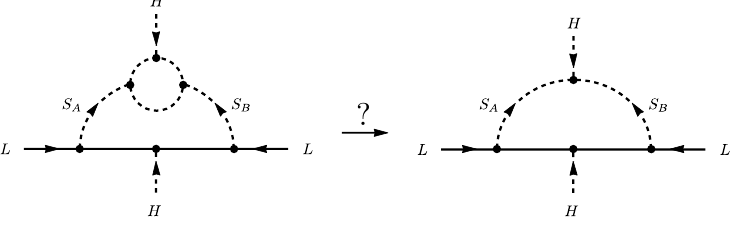
Figure 4 . This 2-loop realization of the dimension (cid:12)ve Weinberg operator illustrates a loophole in our automatized algorithm for (cid:12)nding genuine n -loops neutrino mass diagrams and topologies (we therefore track these special cases manually). In particular, if the scalar S A (or S B ) is the Higgs (cid:12)elds H , and S B (or S A ) is an SU(2) singlet with the correct hypercharge, then there is no point interaction HS A S B . Hence, the existence of the left diagram does not imply that one can build the diagram on the right, with one loop